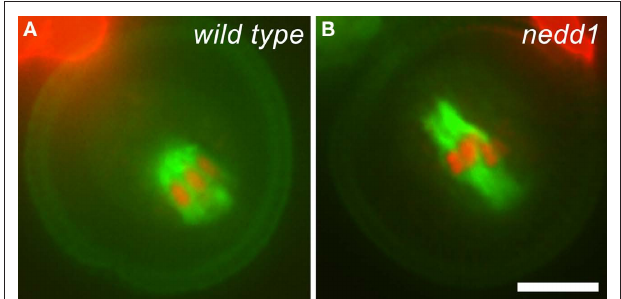
Figure 2 | Mitotic spindles formed in wild type and nedd1 mutant microspores. (A) Anti-tubulin immunofluorescence shows a peripherally positioned spindle (green) with attached chromosomes (red) in a wild type cell. The autofluorescence of the pollen grain highlights its dimension. (B) The nedd1 microspore forms an elongated spindle. Scale bar,